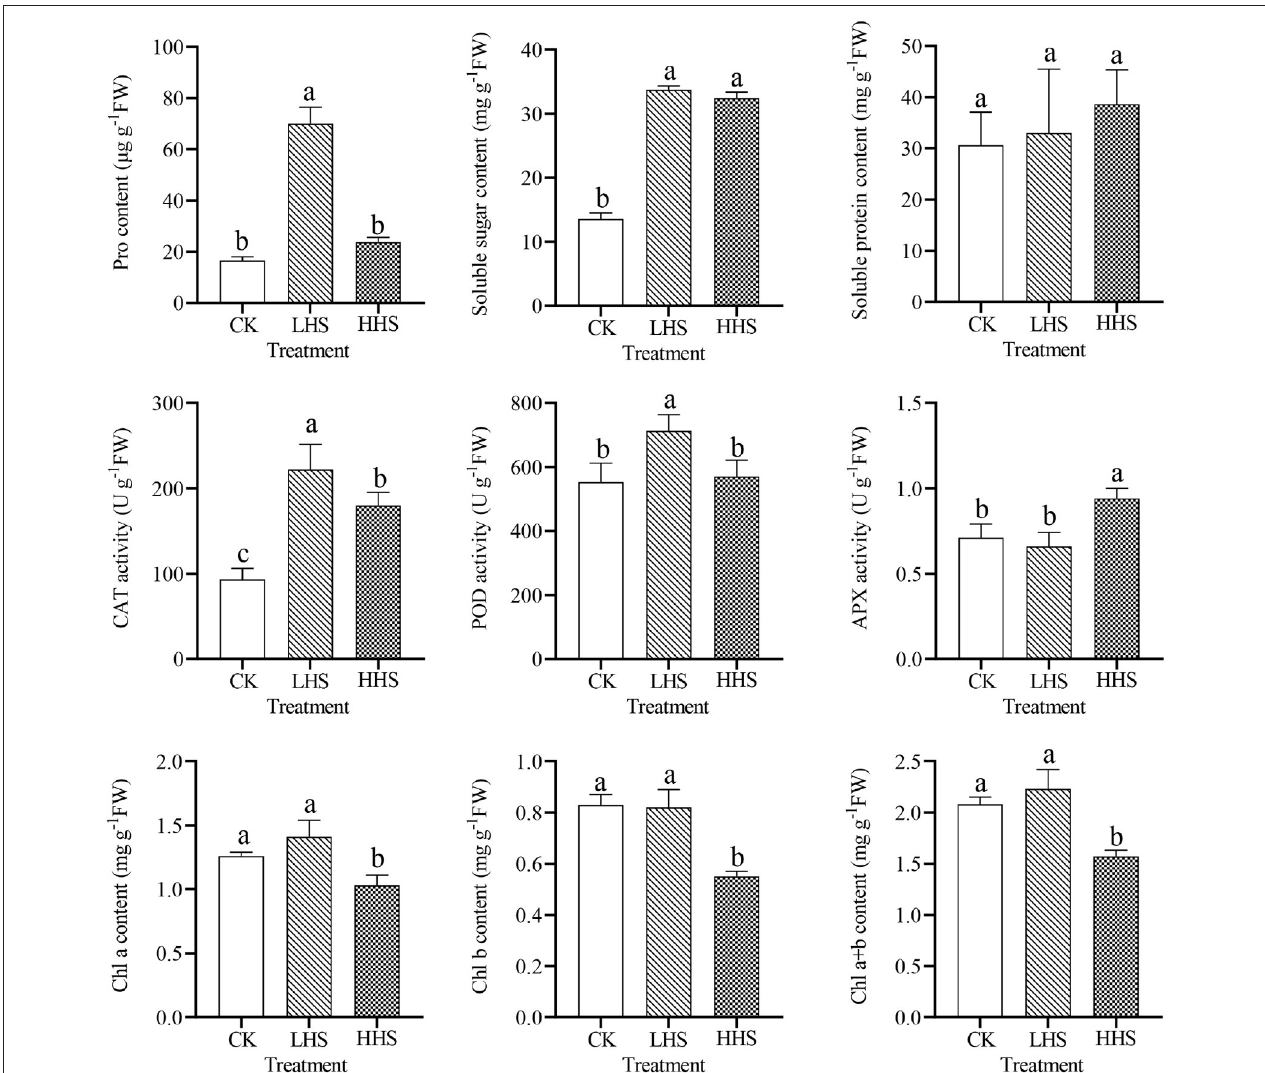
FIGURE 3 | Effect of heat stress on physiological indexes of leaves in Rhododendron simsii . Each value represents the mean ± standard deviation ( n = 4). Different lowercase letters indicate the significant differences. CK, control (25/20 ◦ C); LHS, light heat stress (35/30 ◦ C); HHS, high heat stress (40/35 ◦ C); Pro, proline; CAT, catalase; POD, peroxidase; APX, ascorbate peroxidase; Chl a , chlorophyll a ; Chl b , chlorophyll b ; Chl a + b , chlorophyll a + b .